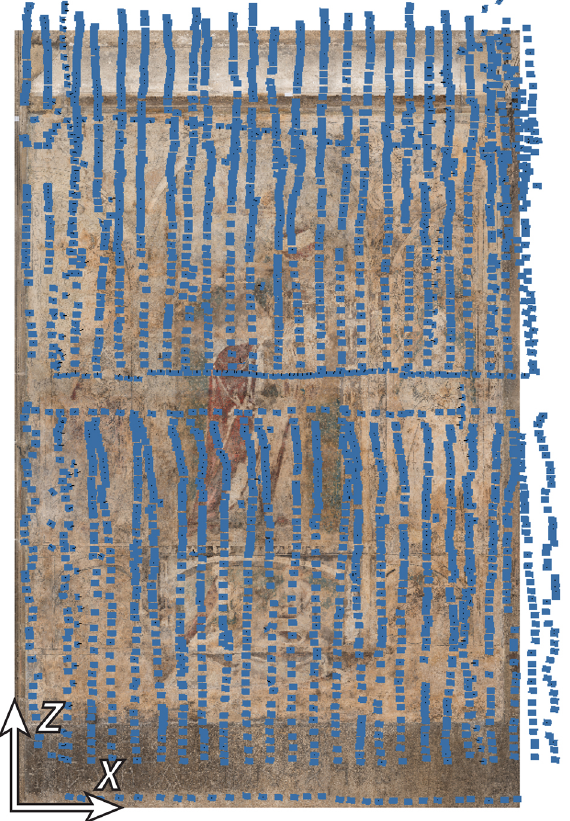
Figure 4 . The network of 2790 photographs. The two horizontal gaps indicate the position of the scaffolding boards. Another two columns of photographs to the far left would be desirable, but the scaffolding and bordering wall prevented